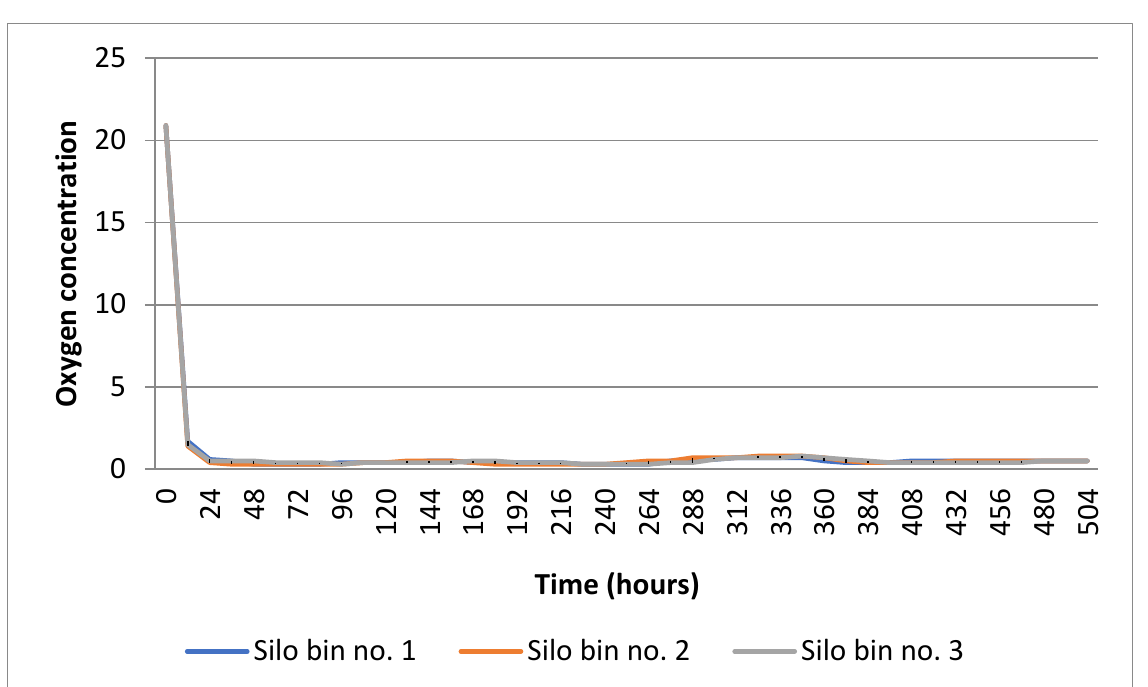
Figure 3. Oxygen concentration during field test — 10 + 1 days of exposure (n = 3 silo units); 1 day N 2 purging; 10 days of full N 2 concentration exposure. The average oxygen concentration after initial 12 h nitrogen purging was 1.5 ± 0.1%; the average oxygen concentration for the 10 days of nitrogen maintenance was 0.4 ± 0.0%.